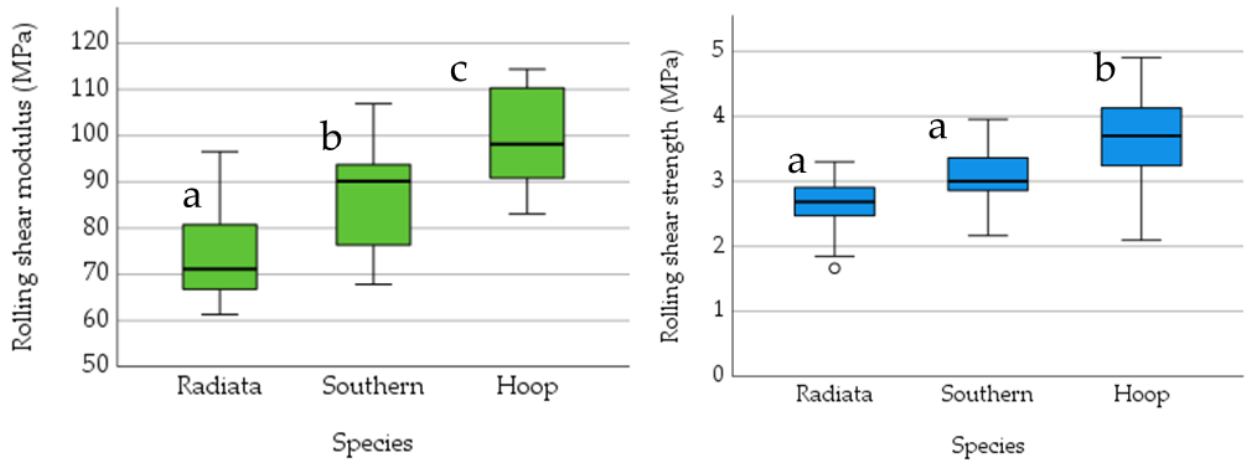
Figure 13. Boxplot showing rolling shear modulus ( left ) and strength ( right ) for various species.